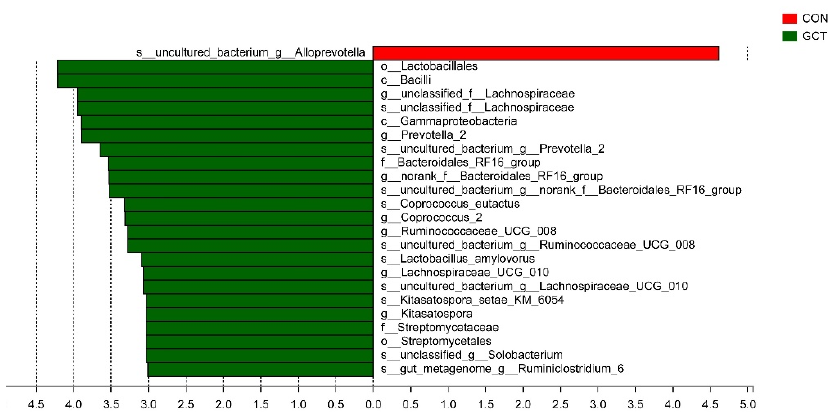
Figure 4. Differences between bacterial taxa in control group and GCT-treated group. The histogram shows differentially rich bacteria in the control group and GCT-treated group ranked by linear discriminant analysis (LDA) scores. Red bars represent the bacteria in the control group are richer than in the GCT-treated group. Green bars represent the bacteria in the GCT-treated group are richer than in the control group; c: class level, o: order level, f: family level, g: genus level, s: species level.